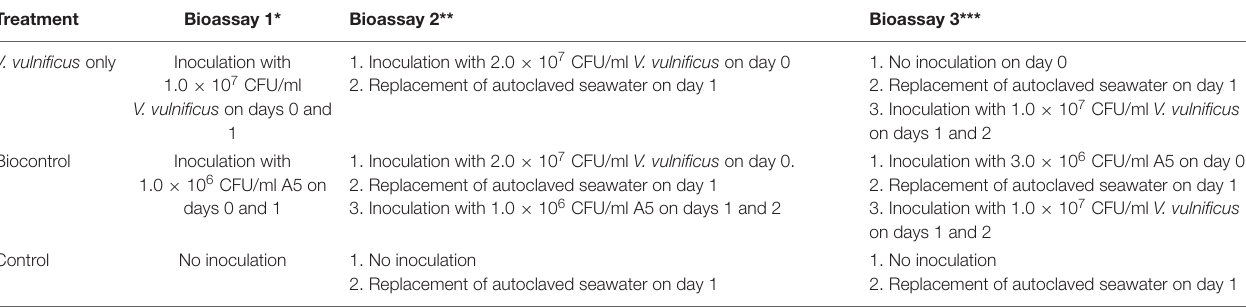
TABLE 1 | Experiments with live oysters in autoclaved seawater.